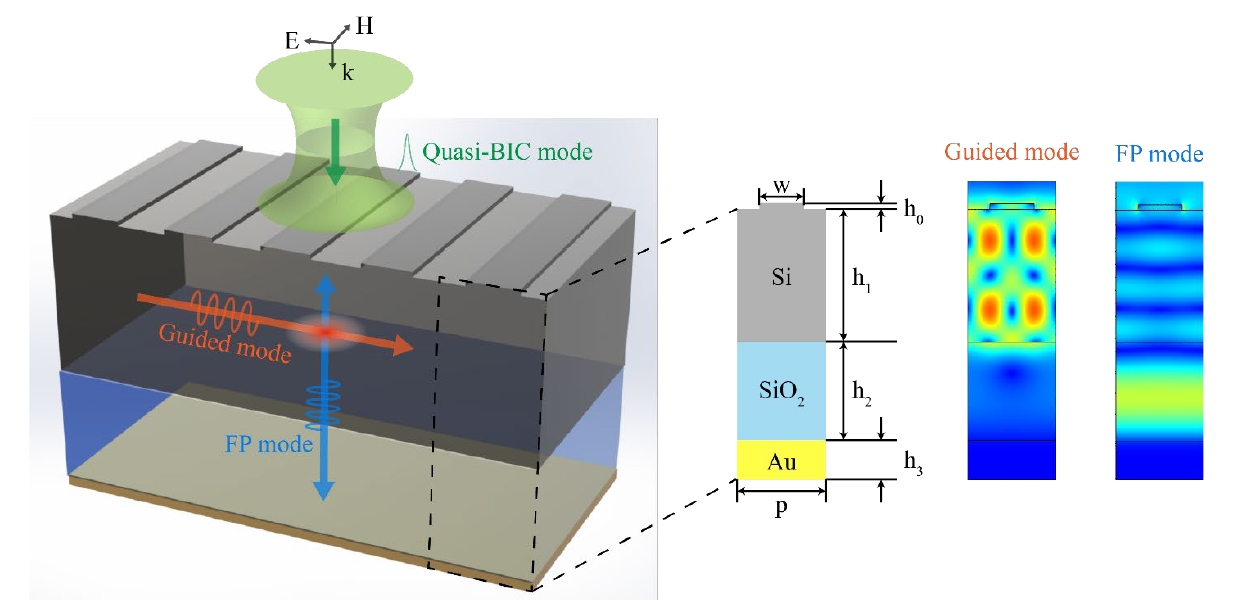
Figure 1. Schematic of the quasi-BIC based high-Q perfect absorber (left panel), the cross-section of a single period (middle panel), and electric field distributions of the guided mode and the FP mode (right panel).